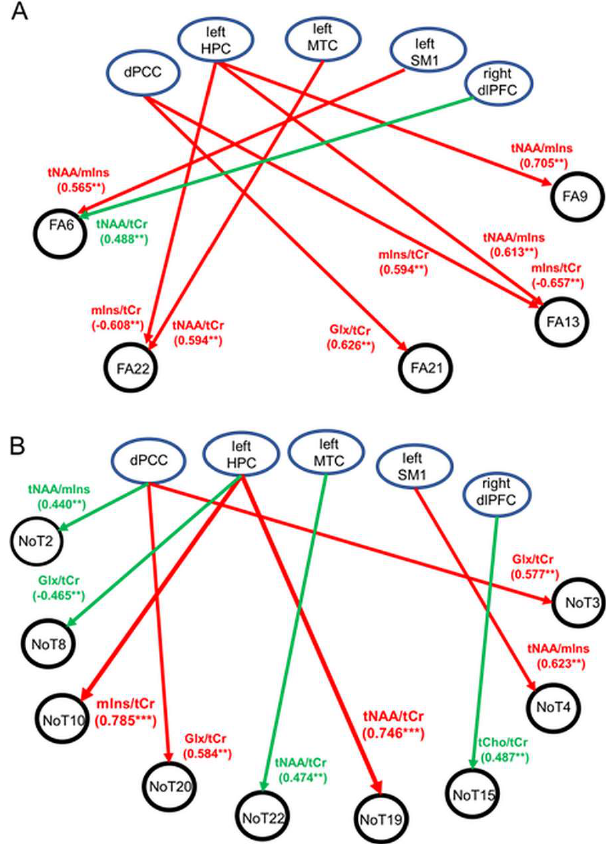
Figure 3. Schematic illustration showing significant associations ( p < 0.001) or trends ( p < 0.01) be- tween WM tractographic properties and 1 H-MRS neurometabolites in the five regions of interest. ( A ) Associations between fractional anisotropy (FA) and 1 H-MRS neurometabolites. ( B ) Associa- tions between number of tracts (NOT) and 1 H-MRS neurometabolites. Abbreviations: HPC = hippo- campus, DLPFC = dorsolateral prefrontal cortex, SM1 = sensorimotor cortex, MTC = medial tem- poral cortex, dPCC = dorsal posterior cingulate cortex, tNAA = total NAA, Glx = glutamate–gluta- mine complex, mIns = myo-inositol, tCho = total choline, tCr = total creatine. Regions of interest ( ROIs) are identified. ** p ≤ 0.009, *** p < 0.001. Total population (HC + MCI) : A significant negative correlation existed between the number of fiber tracts in the left anterior corona radiata (NOT 8) and left HPC Glx/tCr (r S = −0.500, uncorrected p < 0.001). Trends showing moderate correlations were found be- tween the following: (1) dPCC Glx/tCr and the number of fiber tracts in the left DLPFC (NOT 20) (r S = 0.410, uncorrected p = 0.002); (2) left HPC tCho/tCr and FA of the right SM1 (FA 17) (r S = 0.402, uncorrected p = 0.004); (3) left HPC mIns/tCr and the number of fiber tracts in the superior right corona radiata (NOT 11) (r S = −0.391, uncorrected p = 0.005) and FA of the left temporal tapetum (FA 22) (r S = −0.427, uncorrected p = 0.002); (4) left HPC tNAA/mIns and FA of the right posterior corona radiata (FA 9) (r S = 0.372, uncorrected p = 0.008); (5) left MTC tNAA/tCr and the number of fiber tracts in the left temporal tapetum (NOT 22) (r S = 0.385, uncorrected p = 0.009); and (6) right DLPFC tNAA/tCr and FA of the